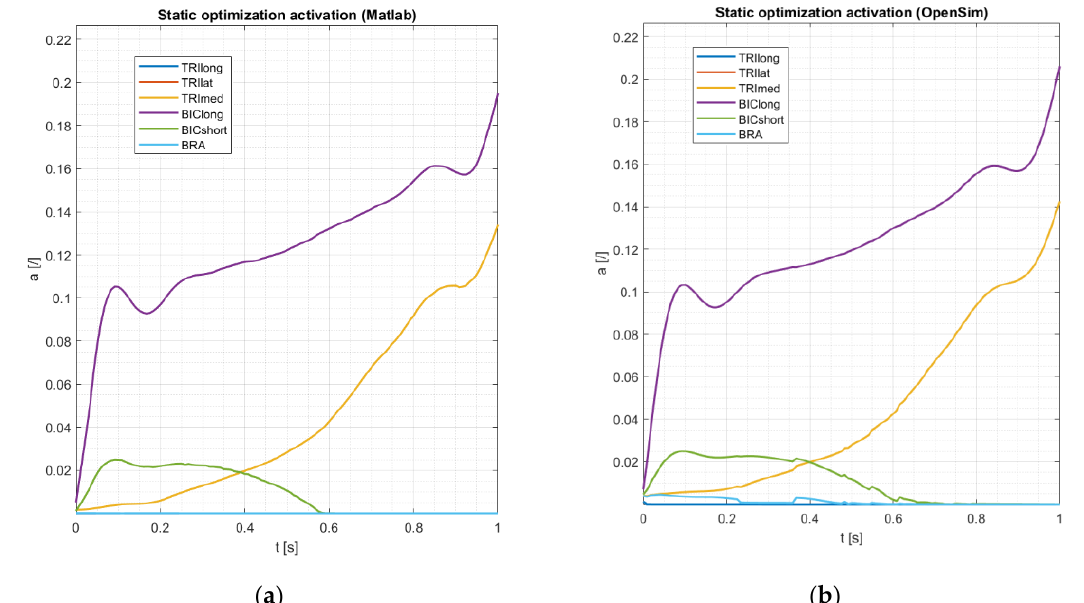
Figure 14. Muscles’ activations with non-physiological criterion and no passive forces: ( a ) Matlab and ( b ) OpenSim.